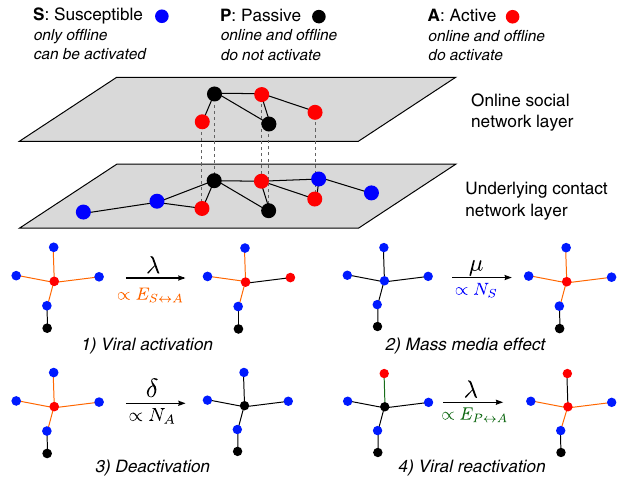
FIG. 2. Illustration of the two-layer model. The upper layer represents the online social network and contains the active and passive nodes. The bottom layer corresponds to the underlying contact network, which contains all nodes. The four dynamical processes are shown in topological illustrations